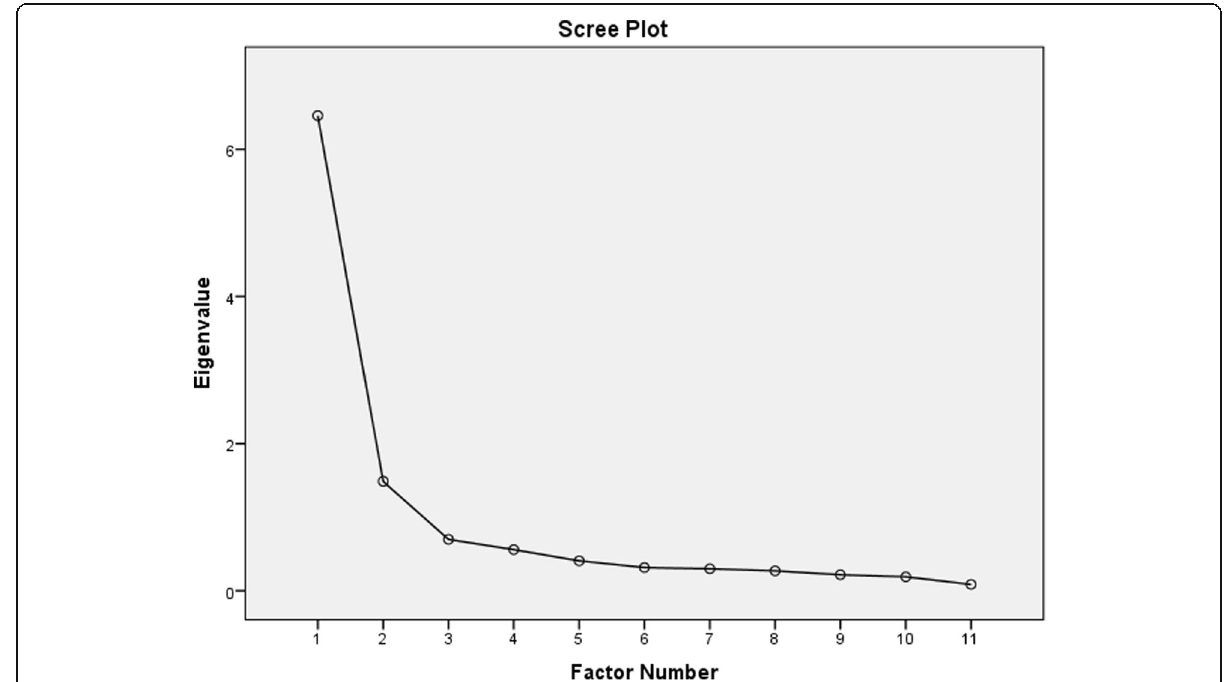
Fig. 5 Scree plot of items on the I-RNLI. KEY : I-RNLI = Igbo version of Reintegration to Normal Living Index